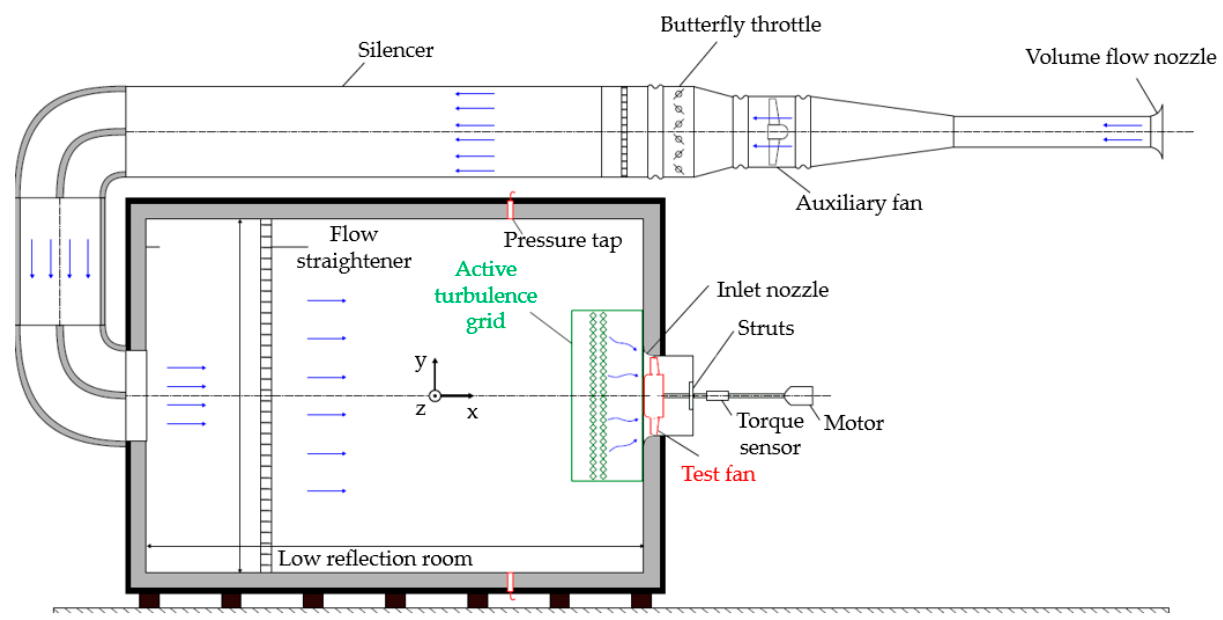
Figure 2. Schematic representation of the axial fan test rig of the LSTM-Erlangen with installed axial fan and active turbulence grid. Design according to DIN EN ISO 5801 [21].